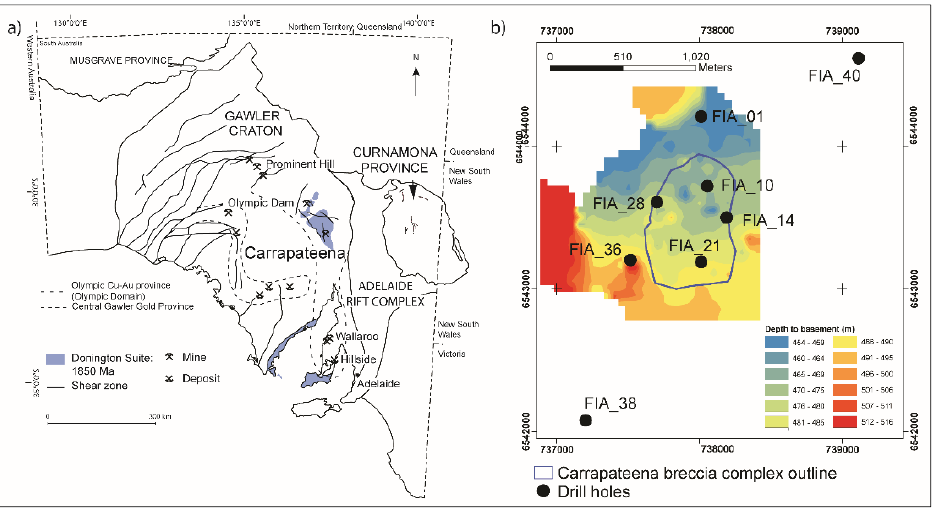
Figure 1. ( a ) Map of the Gawler Craton displaying key mineral deposits and the distribution of Donington Suite plutons within the basement. Modified after [17]. ( b ) Outline of the Carrapateena orebody over a depth to basement map (modified after [11]). The location of drill holes from which samples of the basal diamictite in the overlying cover sequence were taken are shown. The location of the Carrapateena deposit is highlighted in ( a ).